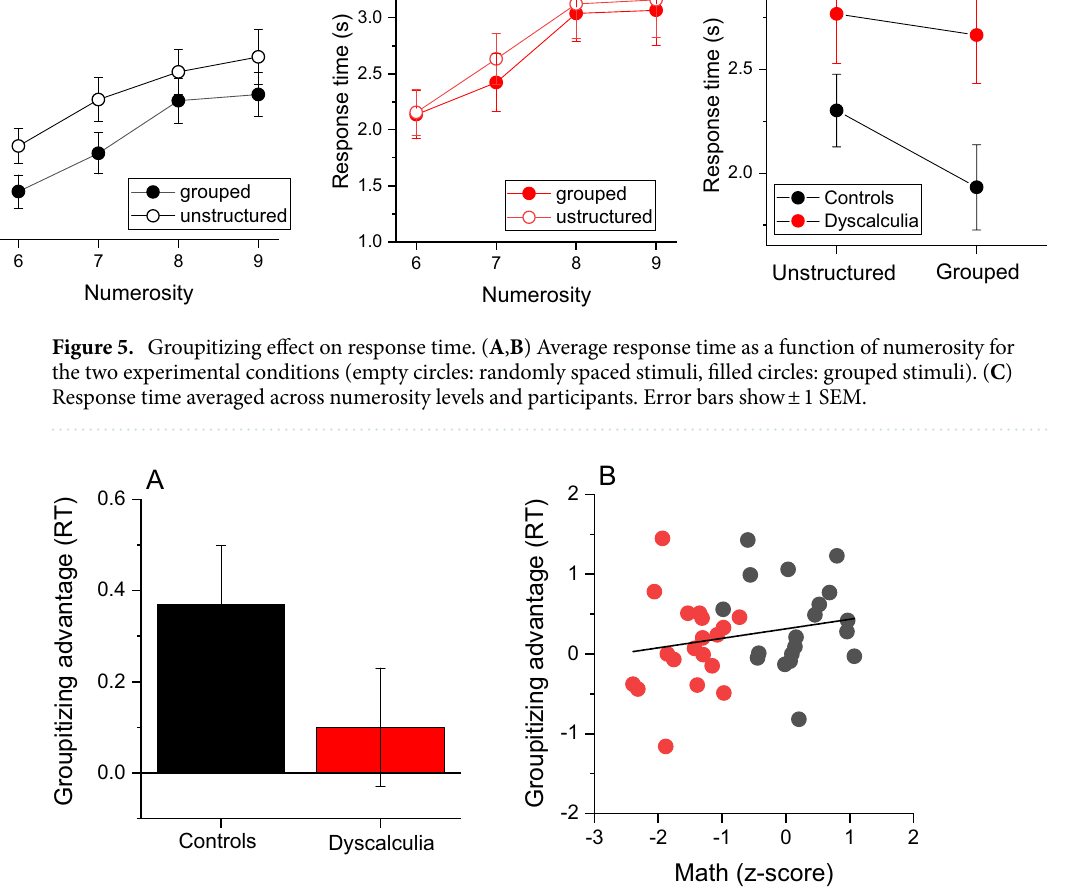
Figure 6. Groupitizing advantage on response time. ( A ) Average standardized difference between response time ( RT , Eq. 1) for grouped and ungrouped stimuli in the sample with dyscalculia and controls. Error bars show ± 1 SEM. ( B ) Linear correlation between groupitizing advantage on response time and math